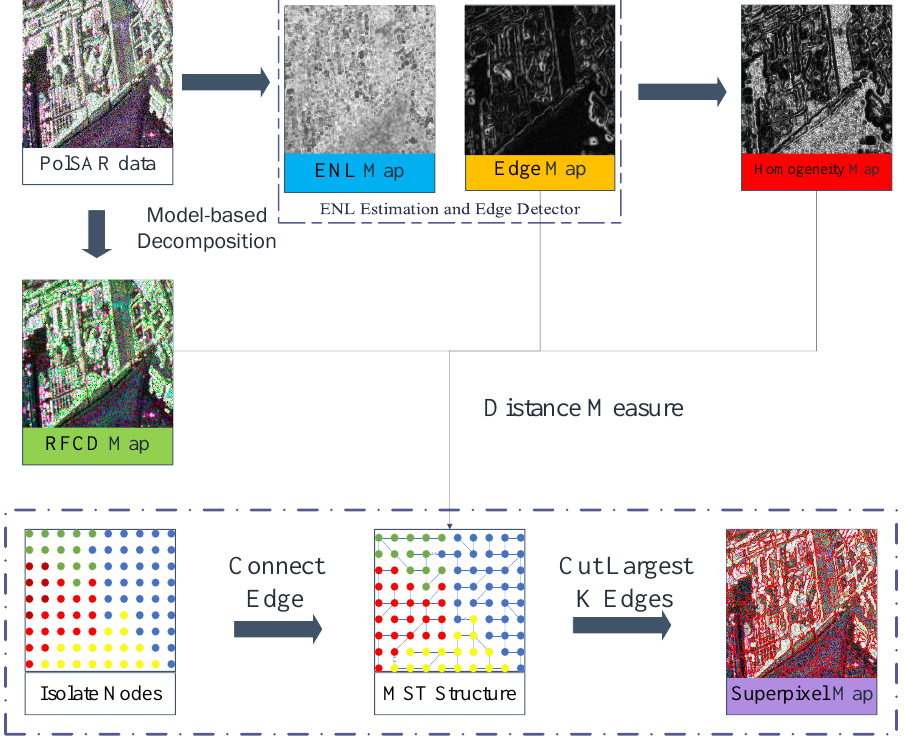
Figure 3. Presentation of the whole schematic concept of the proposed superpixel generation method .